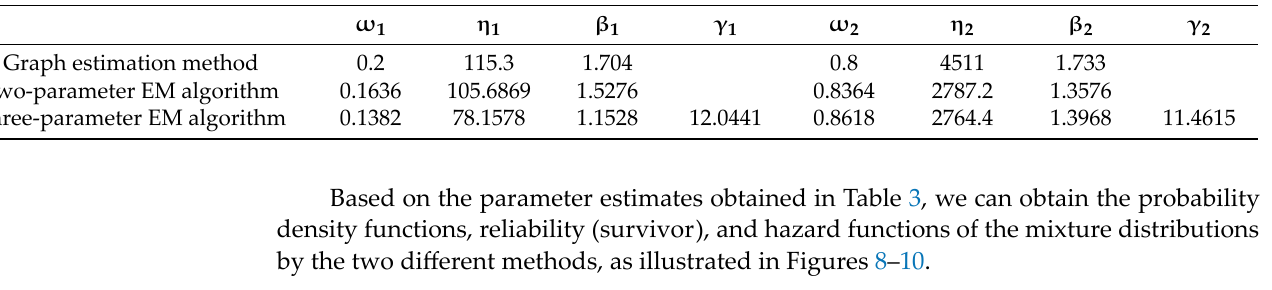
Table 4. Comparison of parameter estimation results.